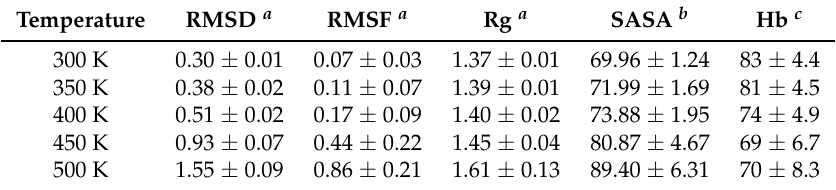
Figure 3. MD simulation analysis of the last 20 ns. ( A ) Root-mean-square deviation (RMSD) showing the high structural instability of systems between 450 K and 500 K. ( B ) Root-mean-square fluctuation (RMSF) plot show high fluctuations at 450 K and 500 K, this analysis was based on the C- α . ( C ) Radii of gyration (Rg) plot shows us the high compactness between 300 to 400 K. ( D ) Solvent Accessibility Surface Area (SASA) plot indicated that exists a large surface area at high temperatures (450 K and 500 K). Table 1. Summary of RMSD, RMSF, Rg, SASA, and Hb average values of the last 20